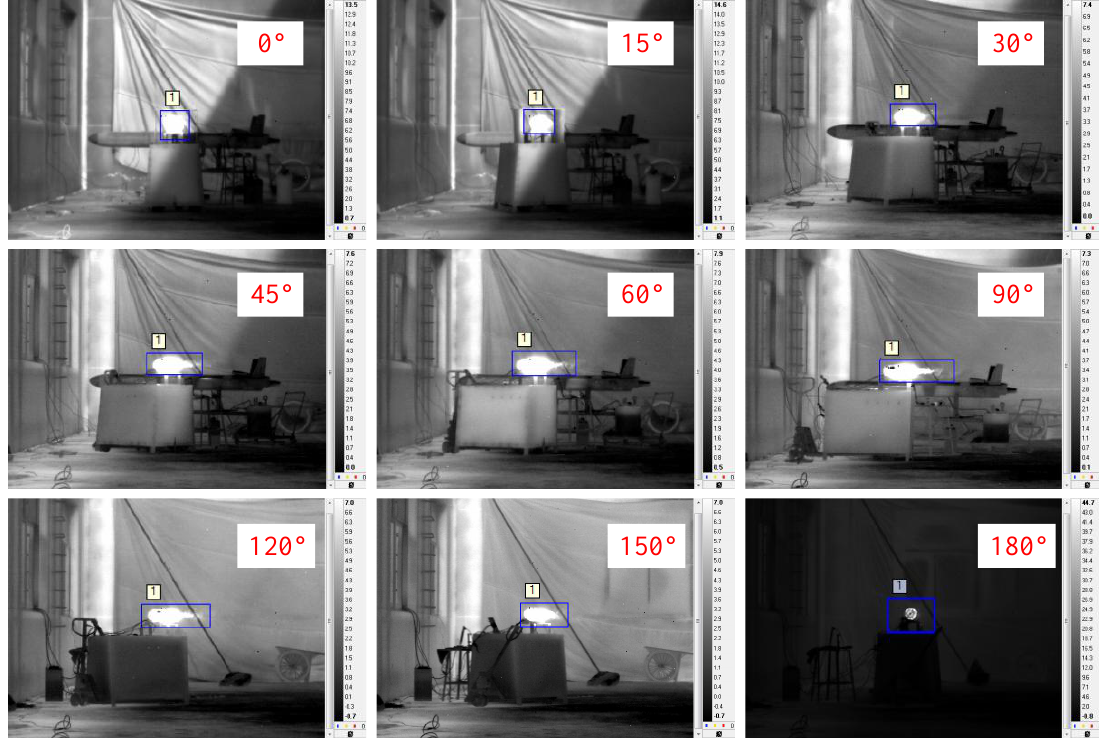
Figure 7. Engine images captured by the long-wavelength infrared (LWIR) camera at different observation angles.